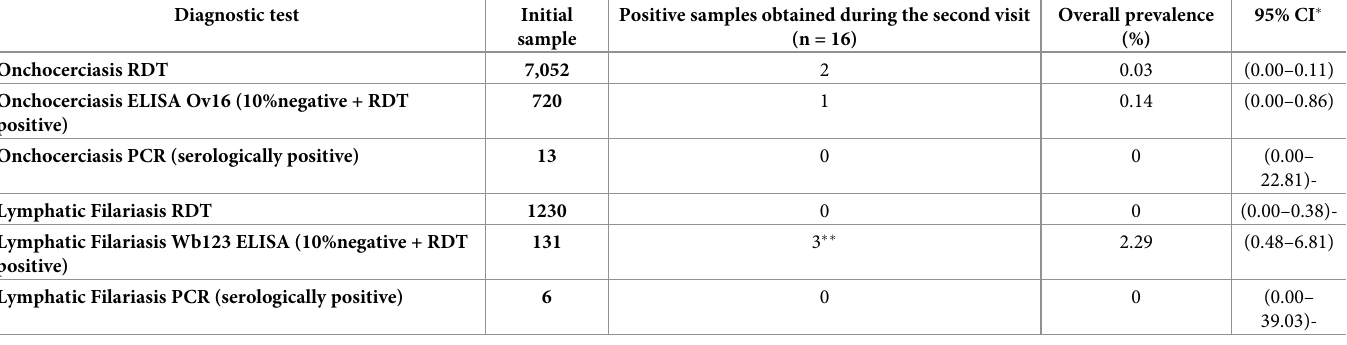
Table 4. Prevalence of onchocerciasis and lymphatic Filariasis in children less than 10 years old tested by RDT, ELISA and PCR, on the second visit, Bioko Island, May